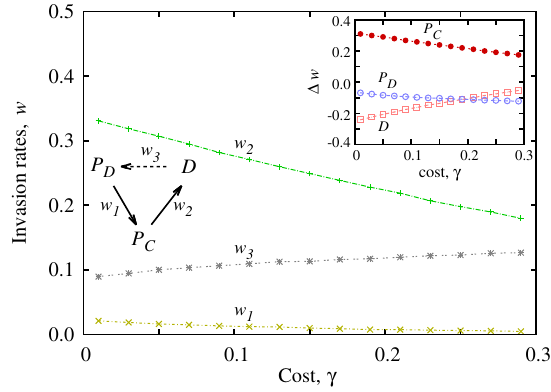
FIG. 8. Invasion rates w between three competing strategies i (see inset) dependent on the punishment cost γ , as obtained for β ¼ 0 . 8 and r ¼ 3 . 0 . We note that D invades P only in the D vicinity of P players, since otherwise the two defecting C strategies are neutral. This fact is indicated by a dashed w 3 arrow. For details on how this specific invasion rate is measured, see the main text. The inset shows the difference Δ w between different pairs of invasion rates, which explains how and why the fraction of strategies changes as a result of the increasing punishment cost (see main text for